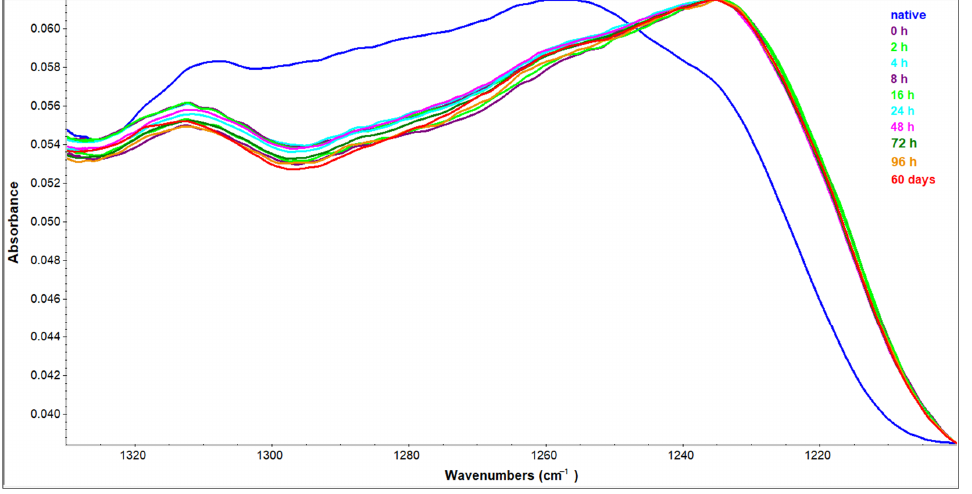
Figure 8. Amide III region of HEWL native sample in H 2 O solution and HEWL samples incubated Figure 8 in 90% C 2 H 5 OH for the time period